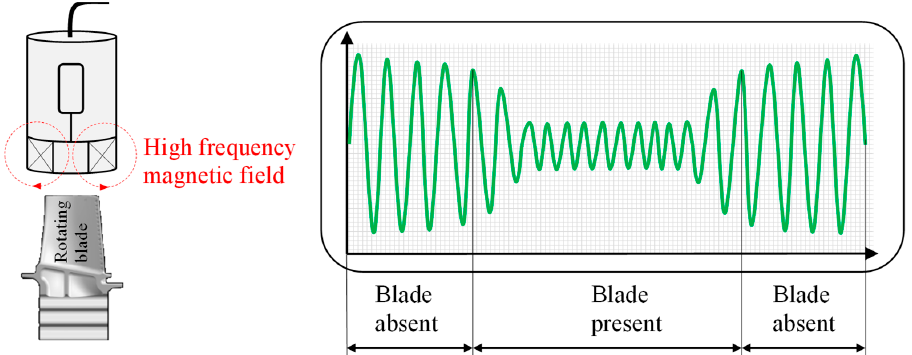
Figure 11 . Principle inductive sensor . Figure 11. Principle inductive